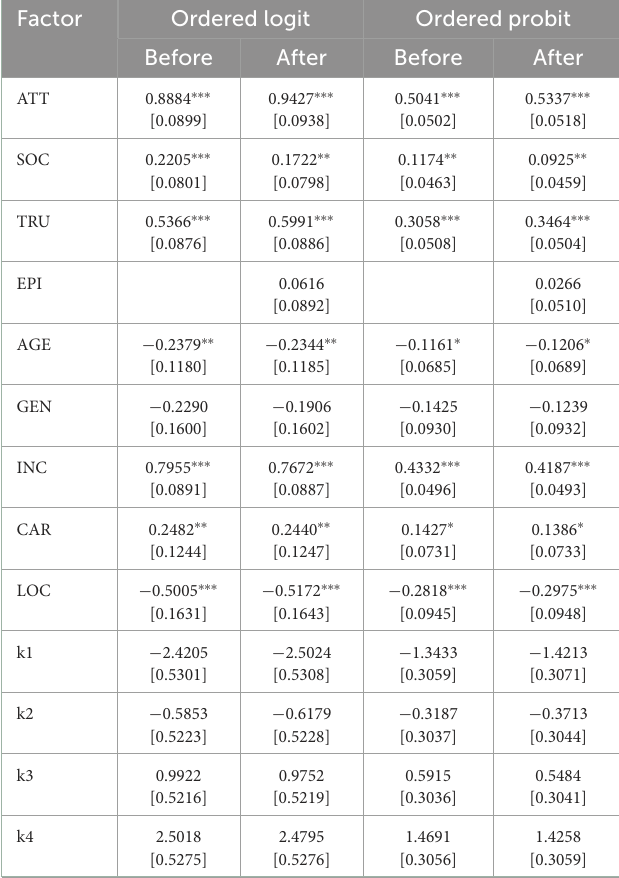
TABLE 2 Comparison of the regression model coefficients before and after the epidemic. Factor Ordered logit Ordered probit Before After Before